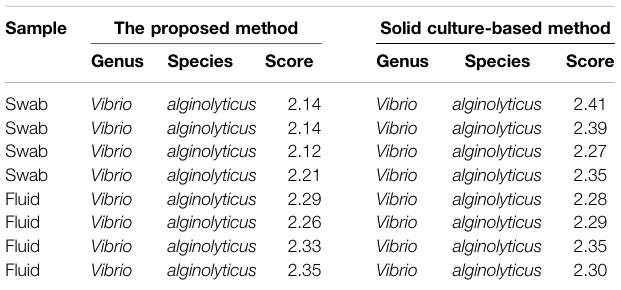
TABLE 1 | MALDI-TOF MS identi fi cation of bacteria in a real case. Sample The proposed